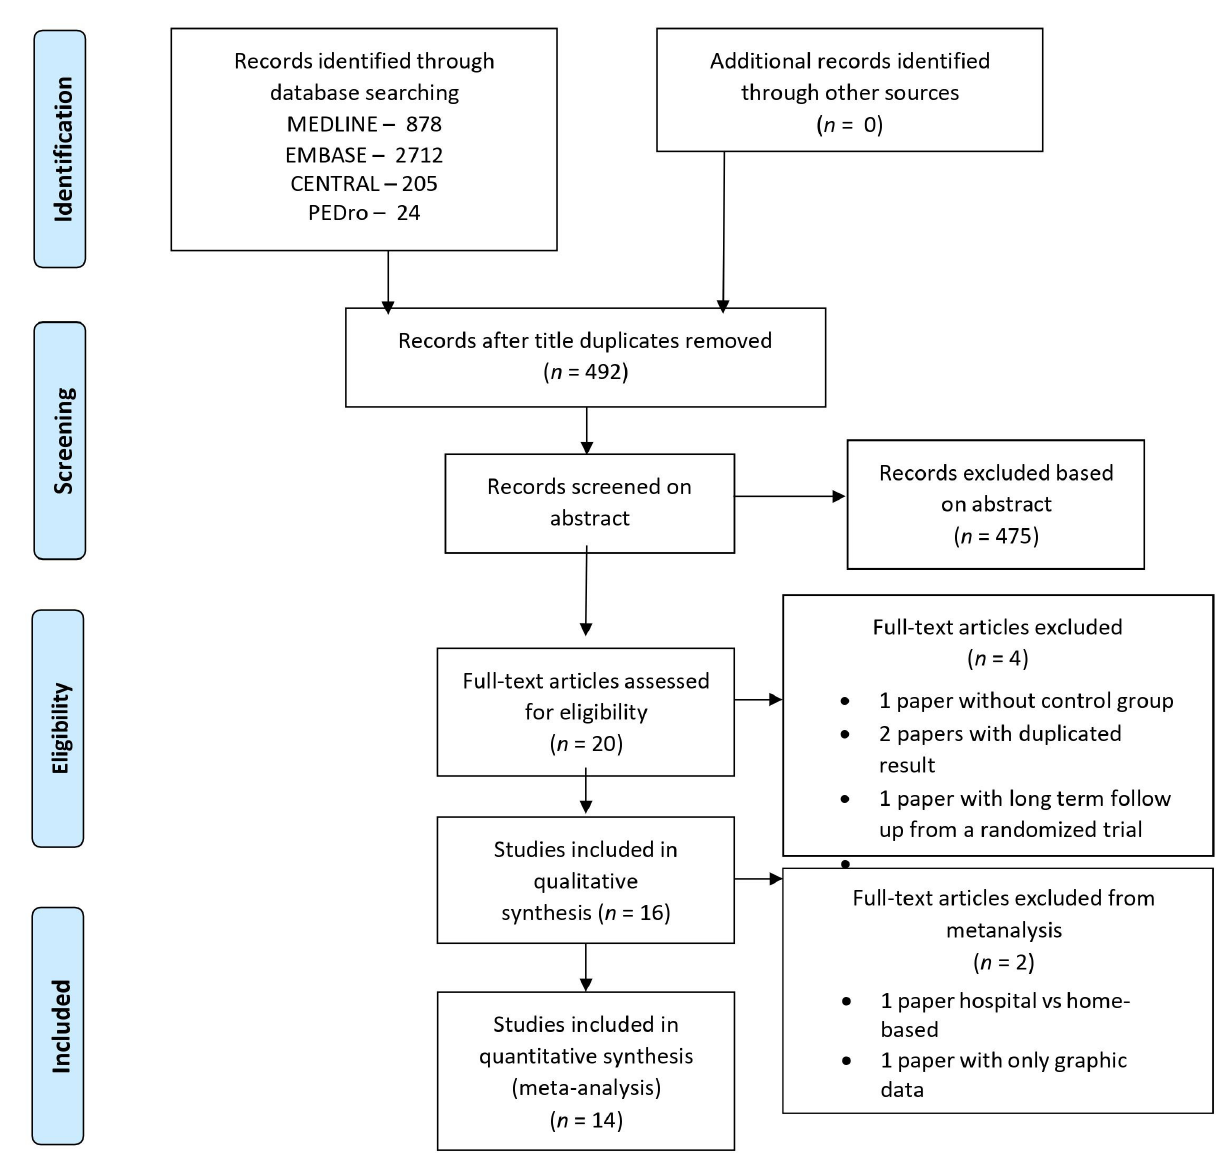
Figure 1. PRISMA Flowchart of the procedures for the selection of articles inserted in the final